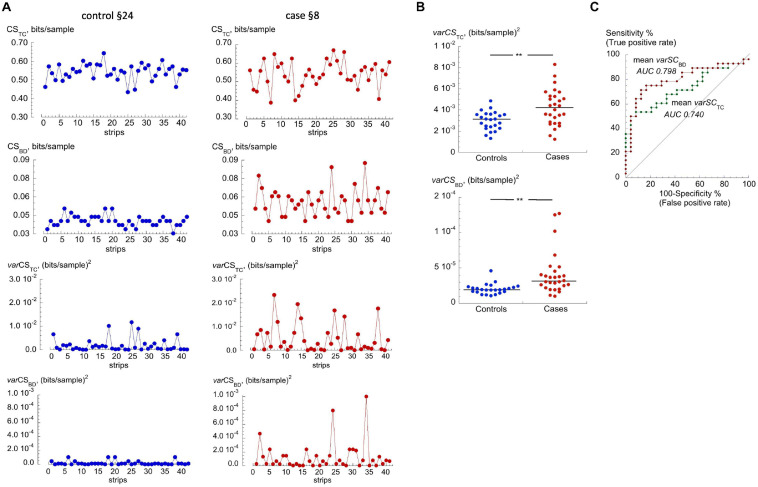
Variability of CSTC and CSBD. (A) Data from for a ‘control (§24)’ and a ‘cases (§8)’ participants. Shown (top to bottom) are CSTC, CSBD, varCSTC and varCSBD values over the recording period. (B) Values of median varCSTC and varCSBD for each participant in the control and cases cohorts; **p < 0.005. (C) ROC curves for varCSTC and varCSBD for discrimination between controls and cases cohorts. AUC values shown by each curve.